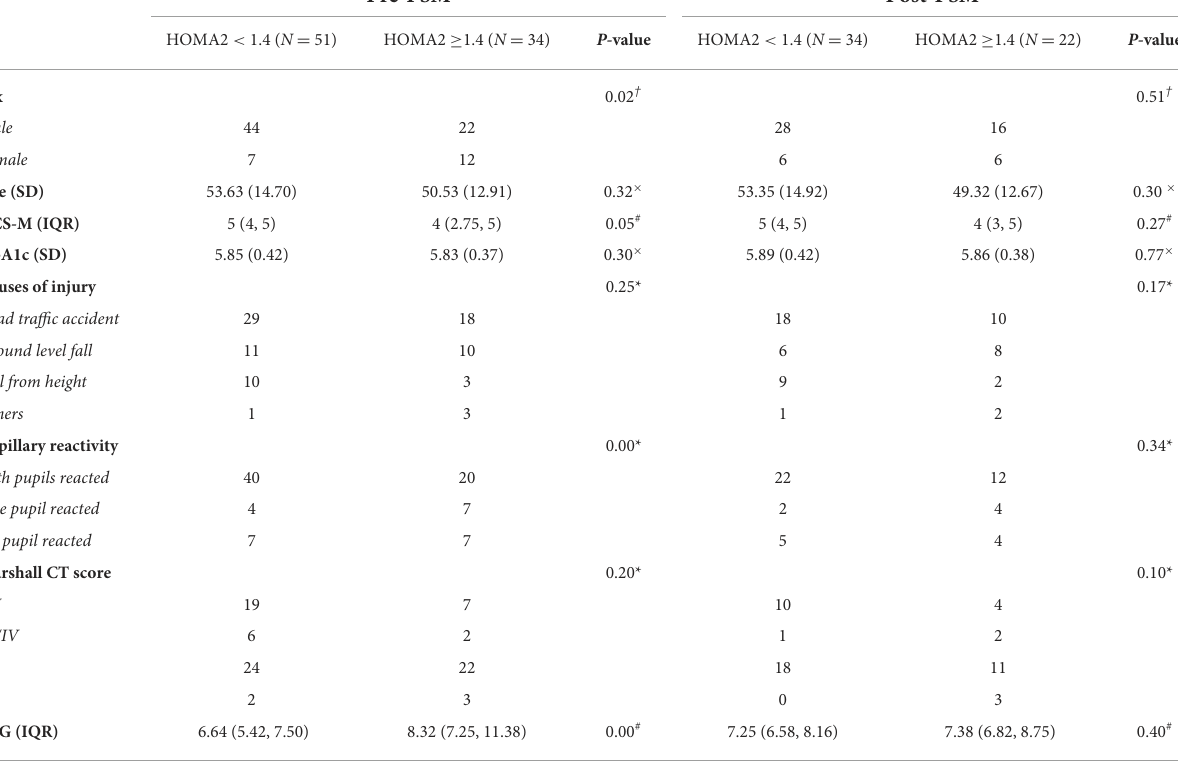
TABLE 1 Baseline data comparison between the two groups before and after propensity score matching (PSM).